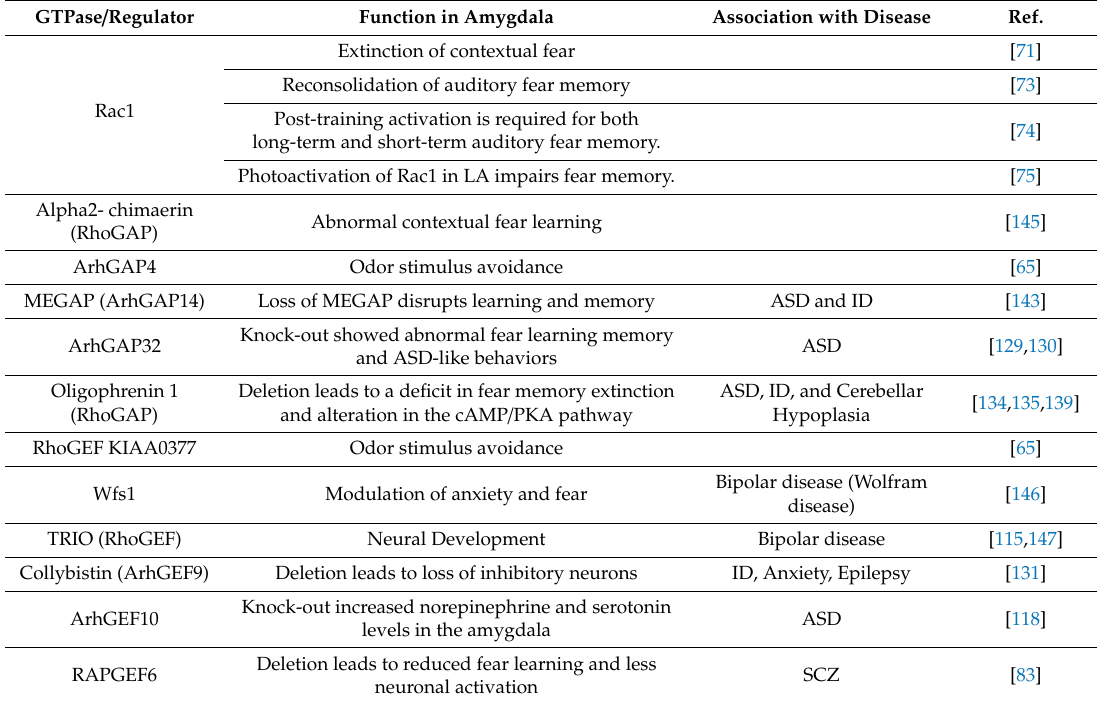
Table 3. The known functions of Rho GTPases and their regulators in the amygdala. GTPase / Regulator Function in Amygdala Association with Disease Ref. Extinction of contextual fear [71] Reconsolidation of auditory fear memory [73] Rac1 Post-training activation is required for both [74] long-term and short-term auditory fear memory. Photoactivation of Rac1 in LA impairs fear memory. Abnormal contextual fear learning Odor stimulus avoidance Loss of MEGAP disrupts learning and memory Knock-out showed abnormal fear learning memory ASD and ASD-like behaviors Deletion leads to a deficit in fear memory extinction ASD, ID, and Cerebellar and alteration in the cAMP / PKA pathway Hypoplasia Odor stimulus avoidance Bipolar disease (Wolfram Modulation of anxiety and fear disease) Neural Development Bipolar disease Deletion leads to loss of inhibitory neurons ID, Anxiety, Epilepsy Knock-out increased norepinephrine and serotonin ASD levels in the amygdala Deletion leads to reduced fear learning and less neuronal activation